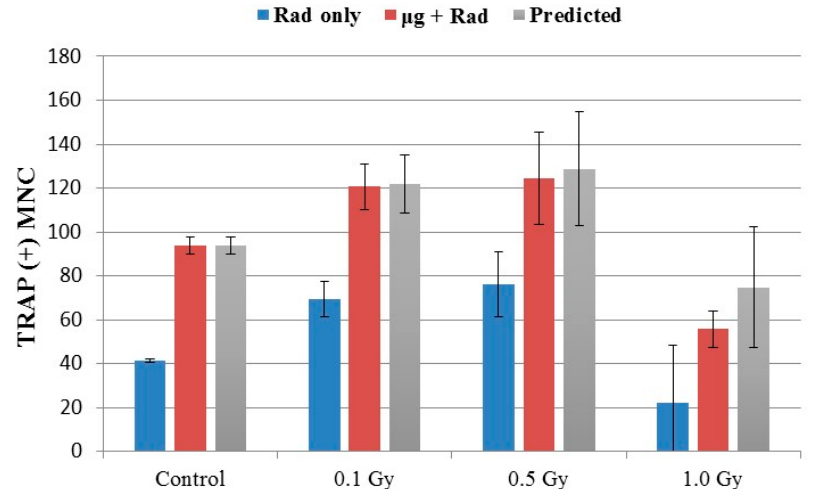
Figure 5. Osteoclast fusion prediction. Blue and red bars represent MNCs containing ≥ 10 nuclei analyzed in Figure 3 for radiation alone and combined radiation and microgravity exposures, respectively. Microgravity alone induced about 52 GMCs (=94 − 42) per dish in comparison to the background (0 Gy). The predicted number based on additive effects of radiation and microgravity (gray bars) is then the sum of this number and the number of GMCs after irradiation alone. For all three doses of 0.1, 0.5, and 1 Gy, the combined effects (red bars) agreed well with the prediction calculated based on the additive effects (gray bars).